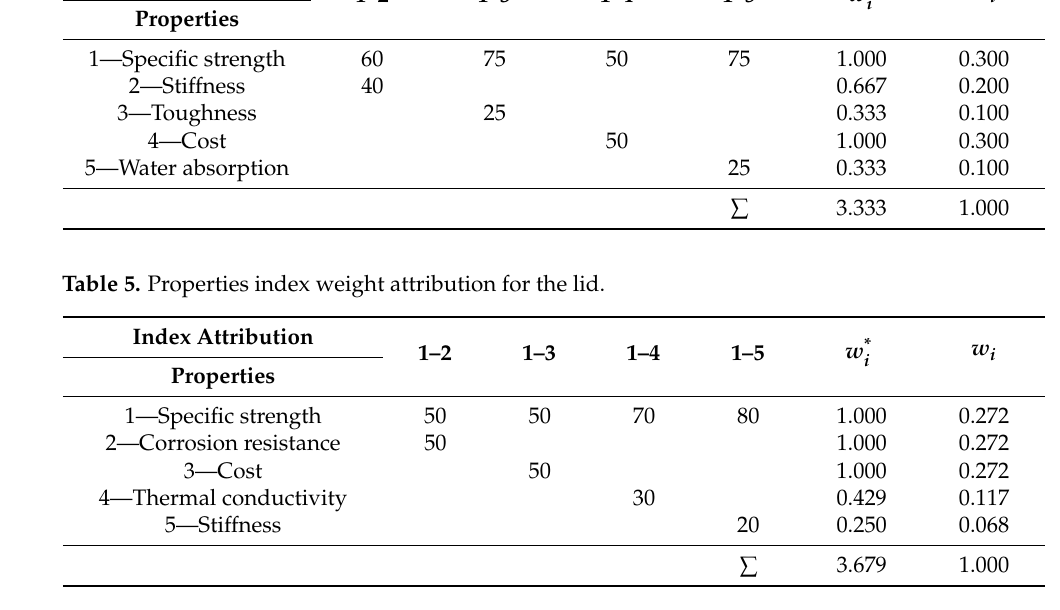
Table 6. Material and weighted index for the box and